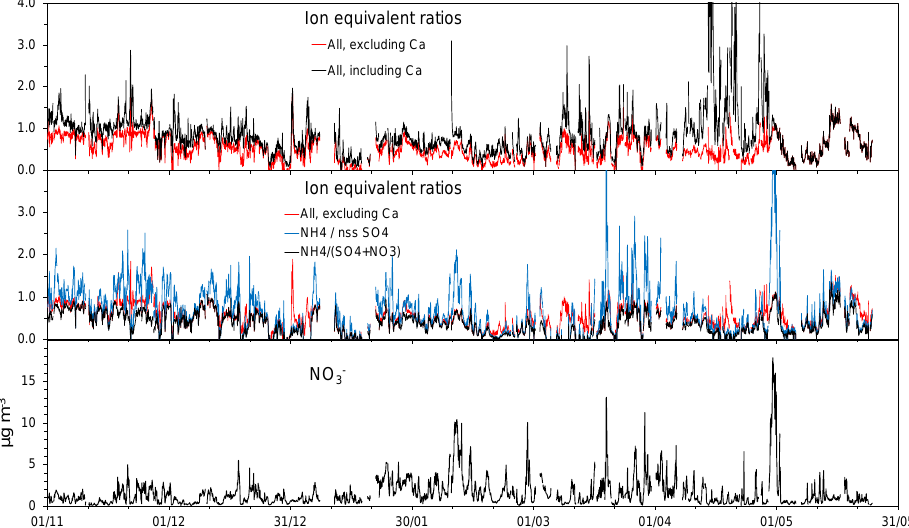
Fig. 13. Studies on the acidity of aerosols in PM 10 . Upper panel: ratio of sums of ion equivalent concentrations of cations to that of anions, including and excluding Ca 2 + concentrations; middle panel: ratio of sums of ion equivalent concentrations of cations to that of anions excluding Ca 2 + concentrations, the ratio of ammonium to non-seasalt sulphate ion equivalent concentrations, and the ratio of ammonium to the sum of non-seasalt sulphate and nitrate ion equivalent concentrations; lower panel: nitrate